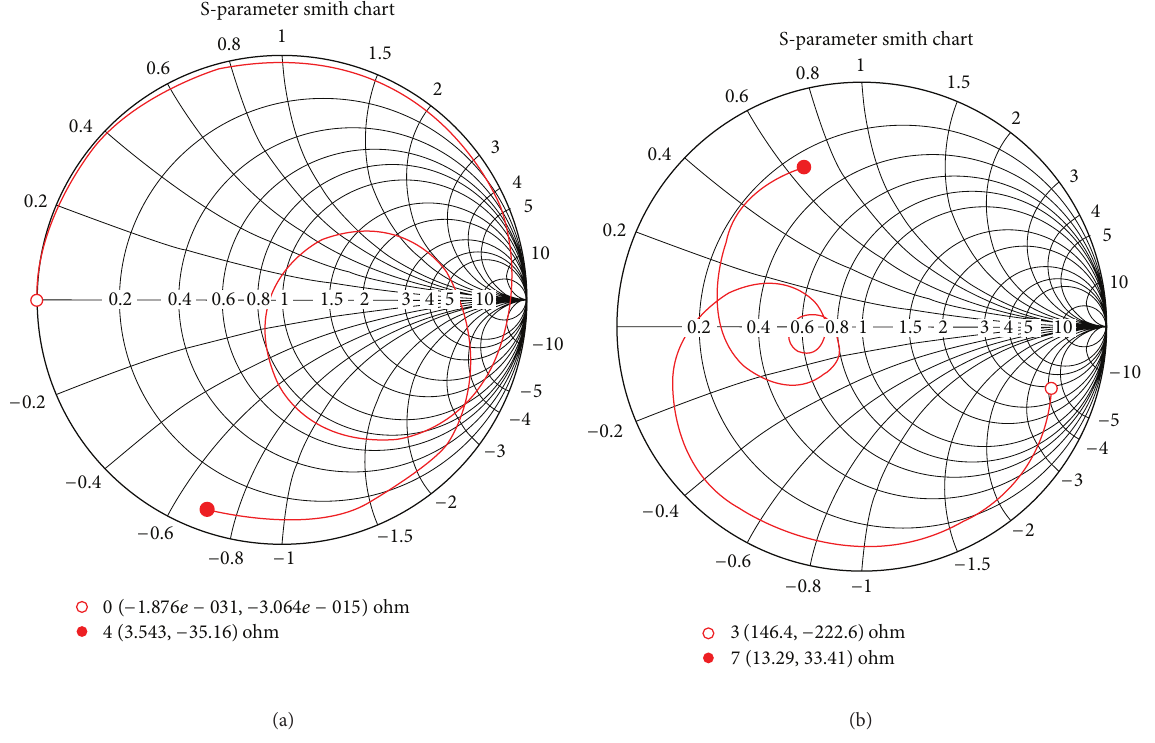
Figure 9: Smith chart of the complex reflection coefficient of the dual-band D-GK2 PIFA in the overlapping frequency ranges DC-4GHz and 3–7GHz.